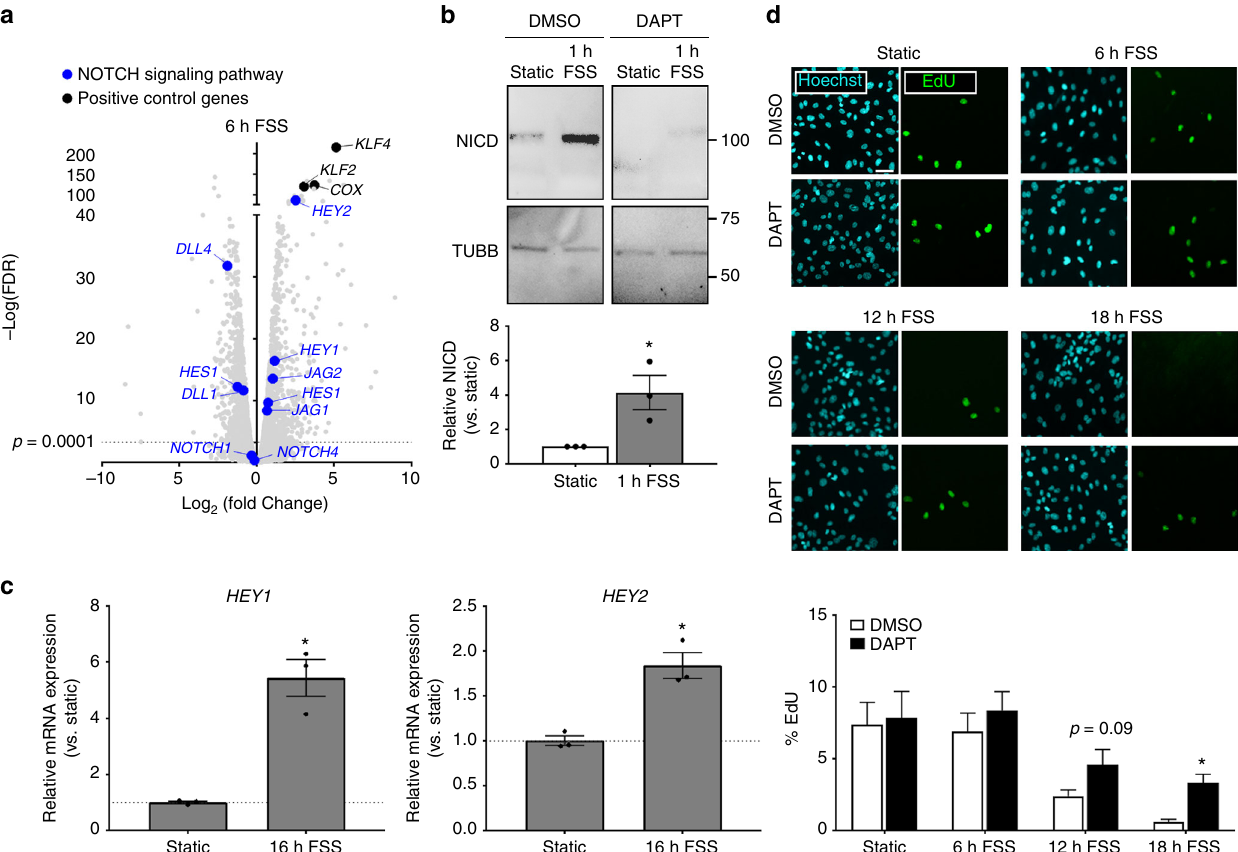
Fig. 1 NOTCH signaling regulates shear-induced endothelial cell quiescence. a Expression of several NOTCH signaling pathway effectors were signi fi cantly altered in whole-transcriptome analysis of HUVEC exposed to 6 h FSS (vs. 6 h Static), as were previously characterized fl ow-responsive genes KLF2 , KLF4 , and COX . b Cleavage of NOTCH receptor intracellular domain (NICD) was signi fi cantly increased with 1 h of 12 dynes/cm 2 FSS (mean densitometry ± SEM; n = 3 for all groups; Students ’ t -test: p = 0.03), and blocked by 10 µ M DAPT. Uncropped blots presented in Supplementary Fig. 1. c HEY1 and HEY2 transcript levels were elevated with 16 h FSS (mean relative mRNA expression ± SEM vs. Static; n = 3 for all groups; Students ’ t -test: p = 0.003 ( HEY1 ), p = 0.005 ( HEY2 )). d EdU incorporation, a measure of DNA synthesis and indicator of proliferation, was reduced over 18 h exposure to FSS in control cells, and this response was abrogated by inhibition of NOTCH signaling (via 10 µ M DAPT) (Colors: Hoechst (cyan), EdU (green); scale bar = 100 µ m; mean % EdU- positive nuclei ± SEM for 8 ROI; representative of n = 3 experiments; Students ’ t -test: p = 0.09 (12 h), p = 0.0006 (18